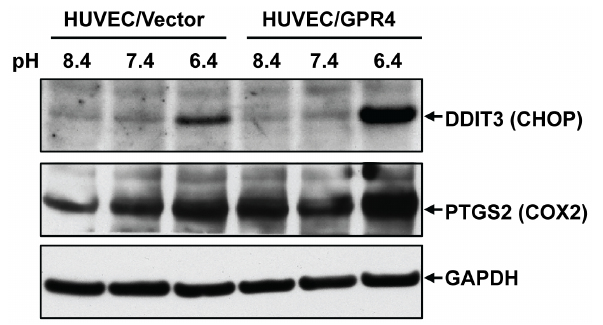
Figure 3. Validation of gene expression at the protein level by Western blotting. HUVEC/Vector and HUVEC/GPR4 cells were treated with EGM-2/HEM media at pH 8.4, 7.4, or 6.4 for 5 h. Cells were then lysed with RIPA buffer, and total proteins were separated by electrophoresis and transferred to nitrocellulose membrane. Protein expression of DDIT3 (CHOP) and PTGS2 (COX-2) was detected using the specific antibodies. The target bands are indicated by an arrow. Western blot of GAPDH serves as a loading control. The results shown are representative of three experiments.